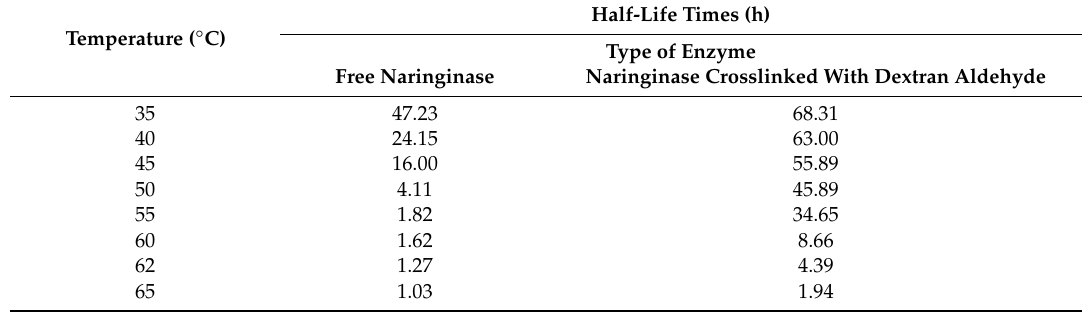
Table 6. Summary of half-life times of free naringinase and naringinase crosslinked with dextran aldehyde depending on